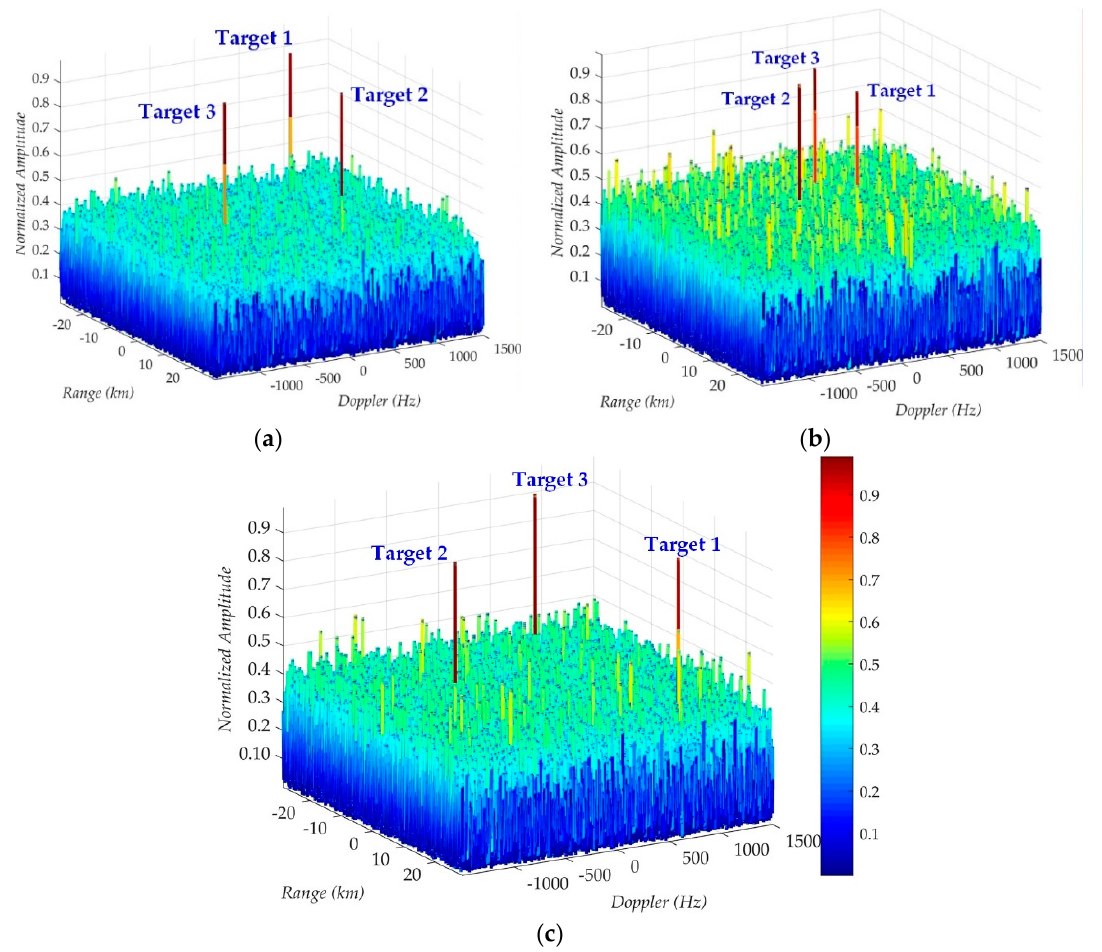
Figure 7. Coherent integration processing results for all targets by the proposed algorithm with different transmitter. ( a ) Results with SVN #2; ( b ) Results with SVN #7; ( c ) Results with SVN #12. The connection between a target’s location, velocity, and range Doppler parameters is: